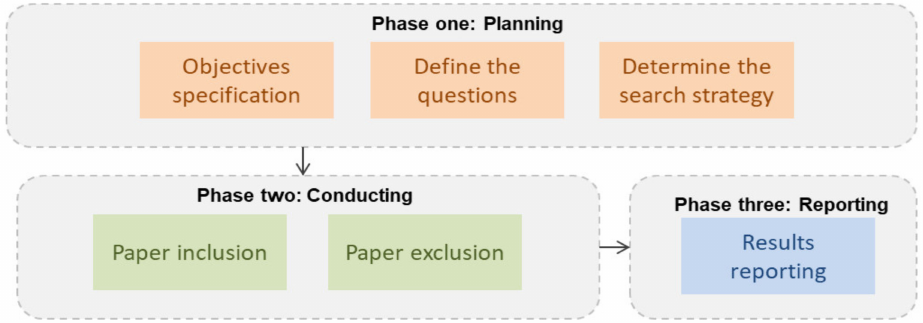
Figure 1. The methodology of the